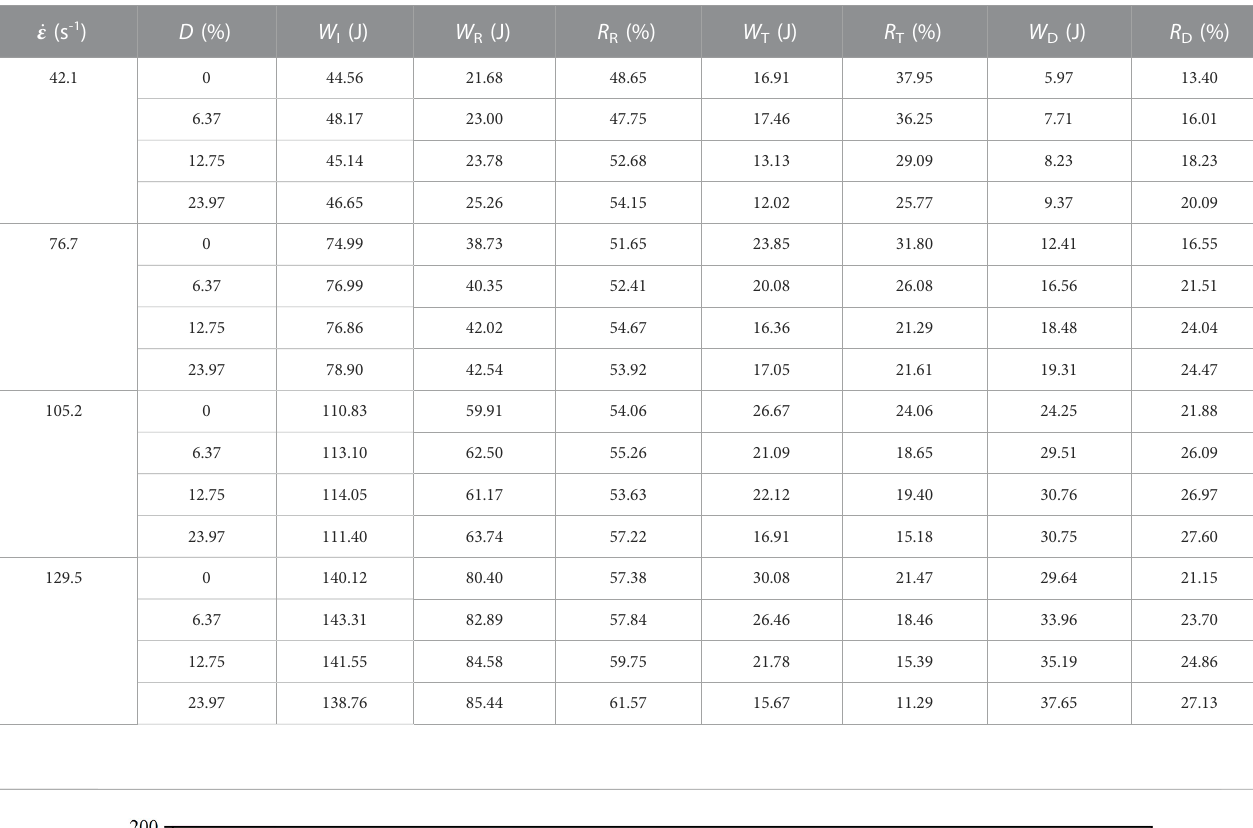
TABLE 4 The energy value during dynamic failure of damaged frozen sandstone.